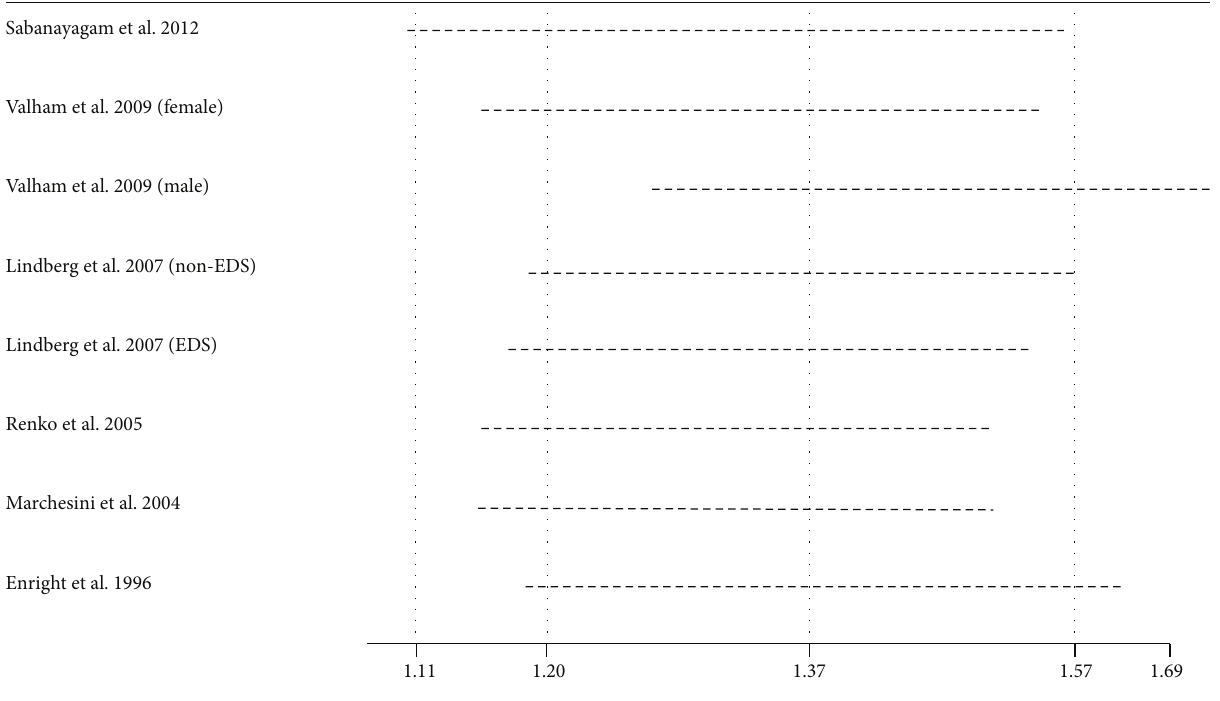
Figure 3: Effect of individual studies on the pooled OR for the self-reported habitual snoring and diabetes mellitus risk.